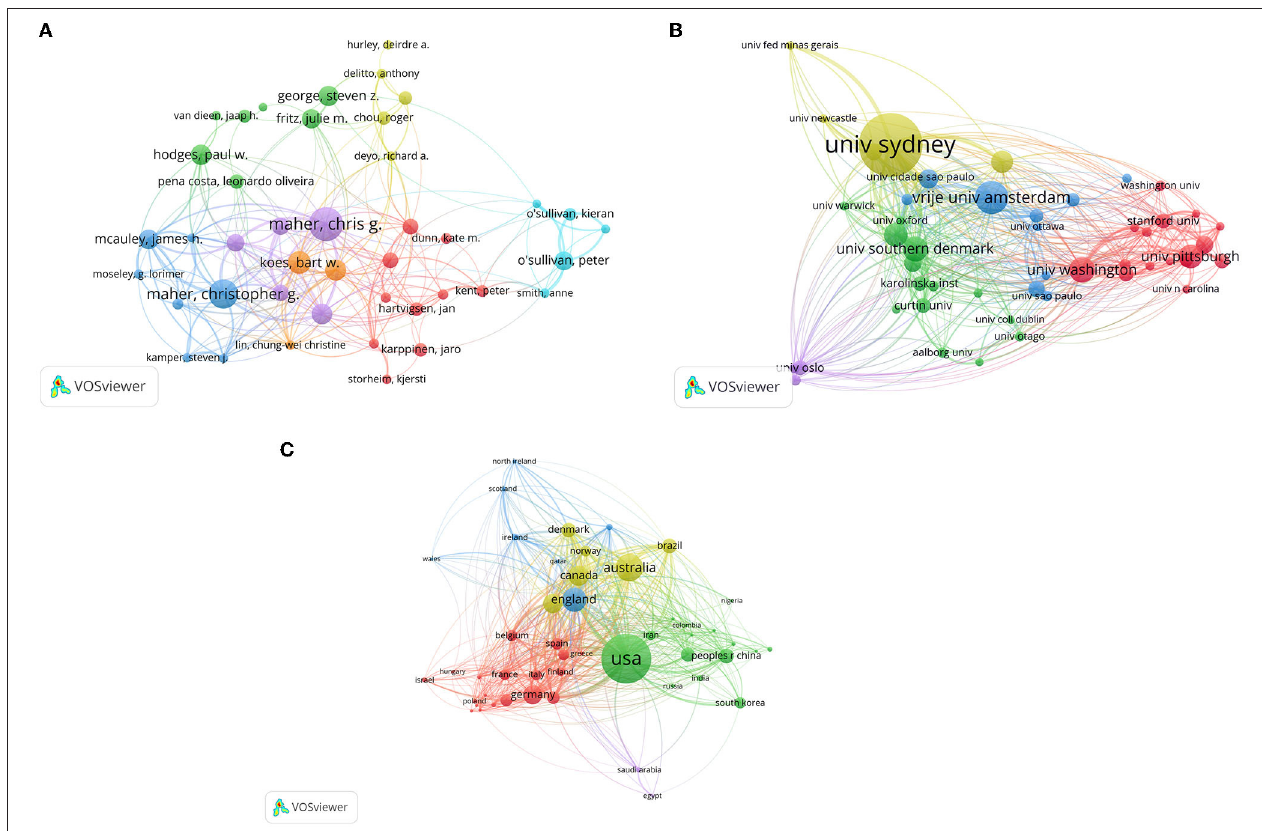
FIGURE 7 | Collaboration of authors, institutions, and countries/regions for LBP research. The thickness of the link between any two authors, institutions, and countries/regions is indicative of the extent of co-authorship, and the colors of the circles indicate groups of authors, institutions, and countries/regions with a high degree of collaboration. (A) Network map of authors. (B) Network map of institutions. (C) International collaboration between